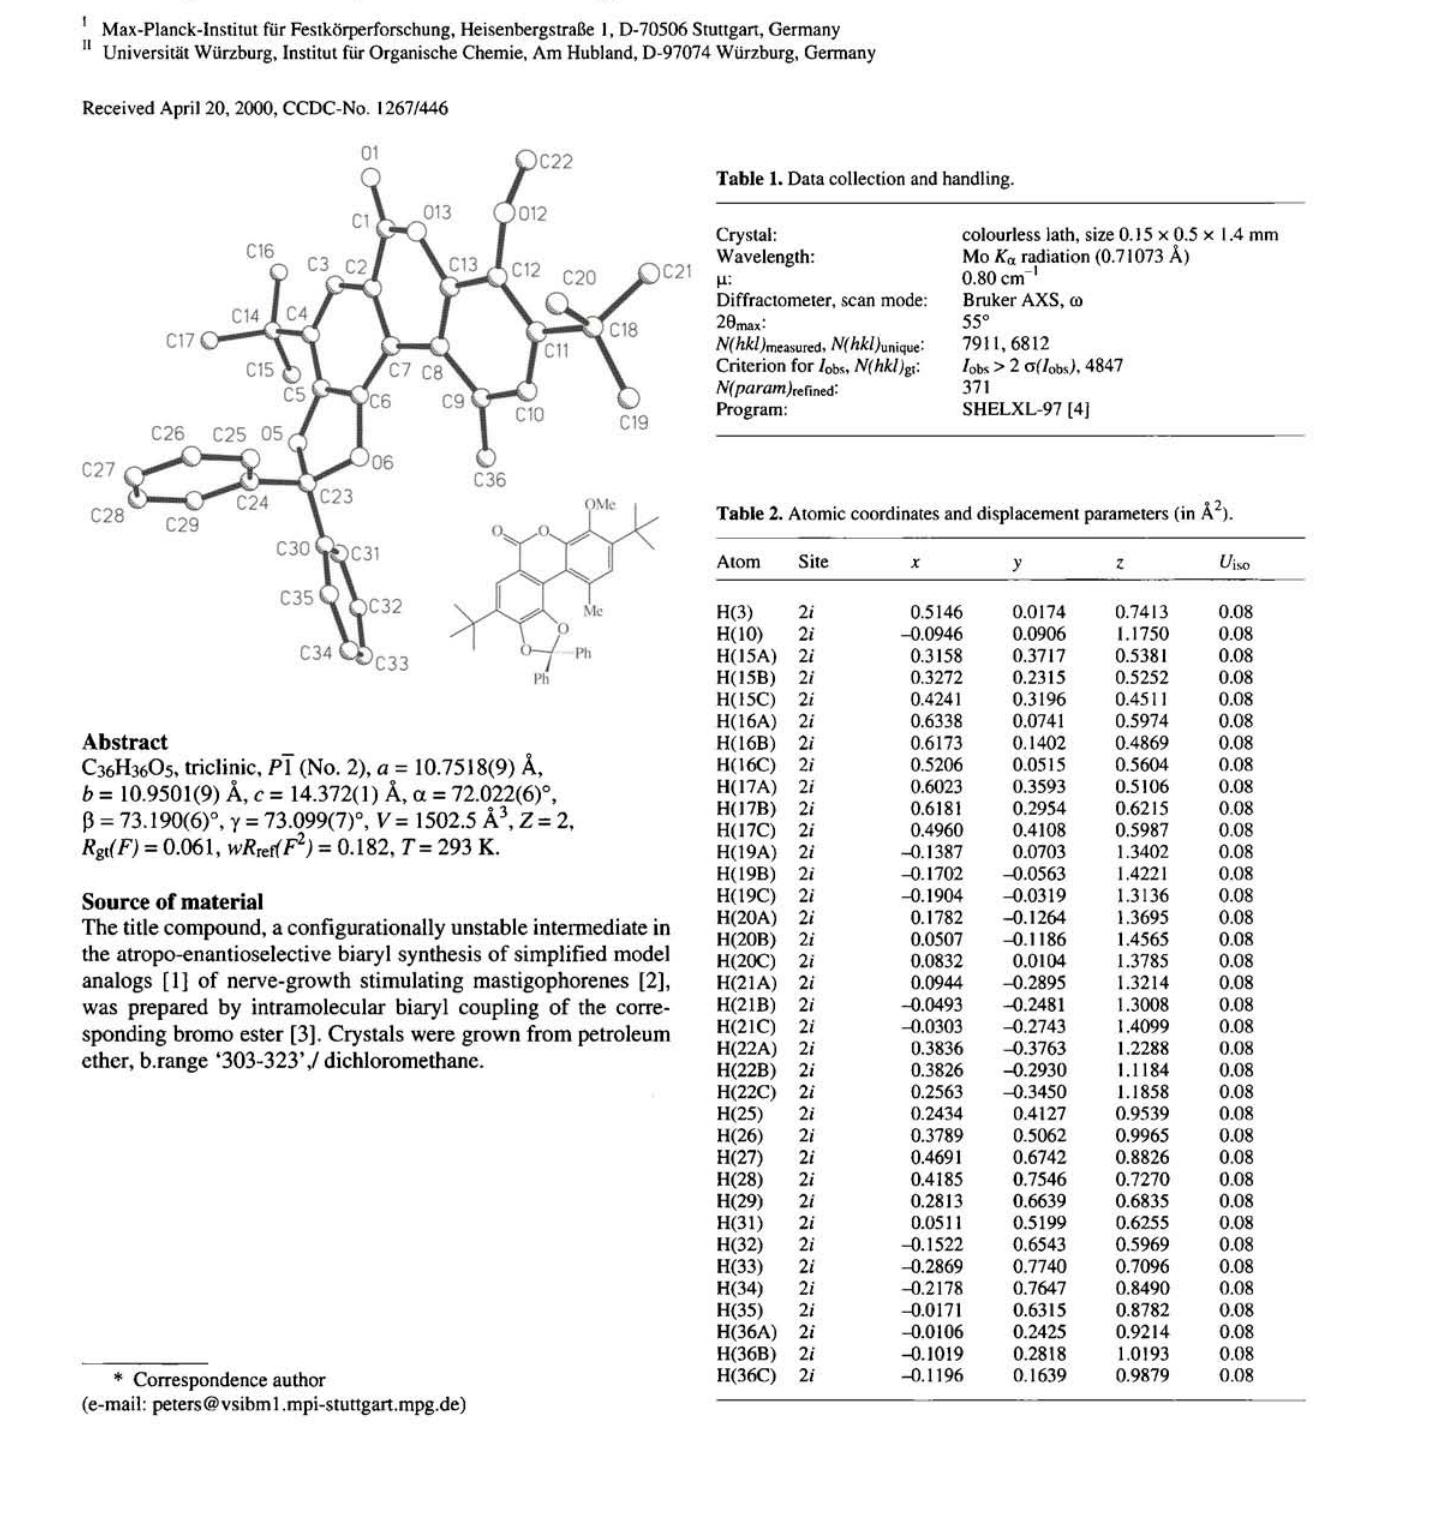
Table 2. Atomic coordinates and displacement parameters (in A